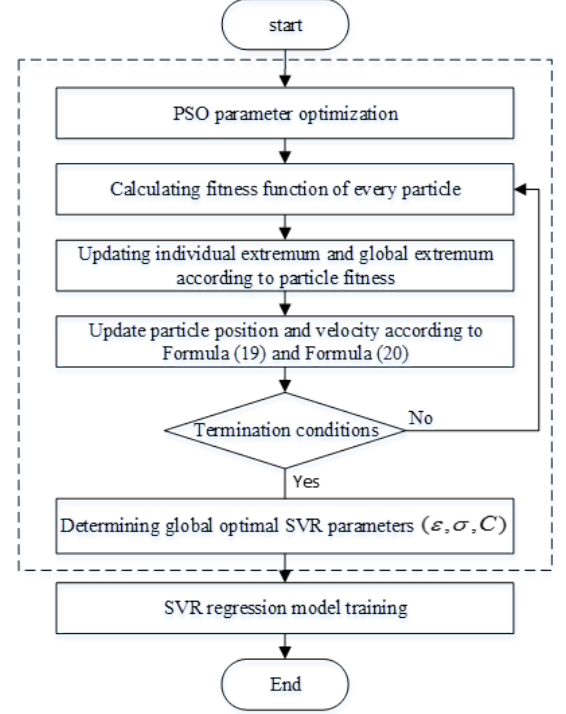
Figure 3. The flow chart of PSO-support vector regression (SVR).